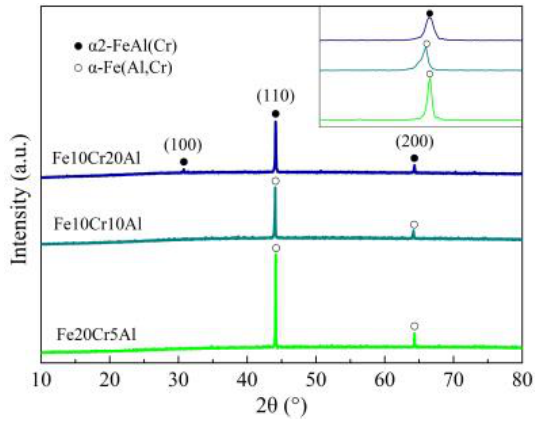
Figure 2. XRD patterns of the synthesized porous Fe-Cr-Al materials.